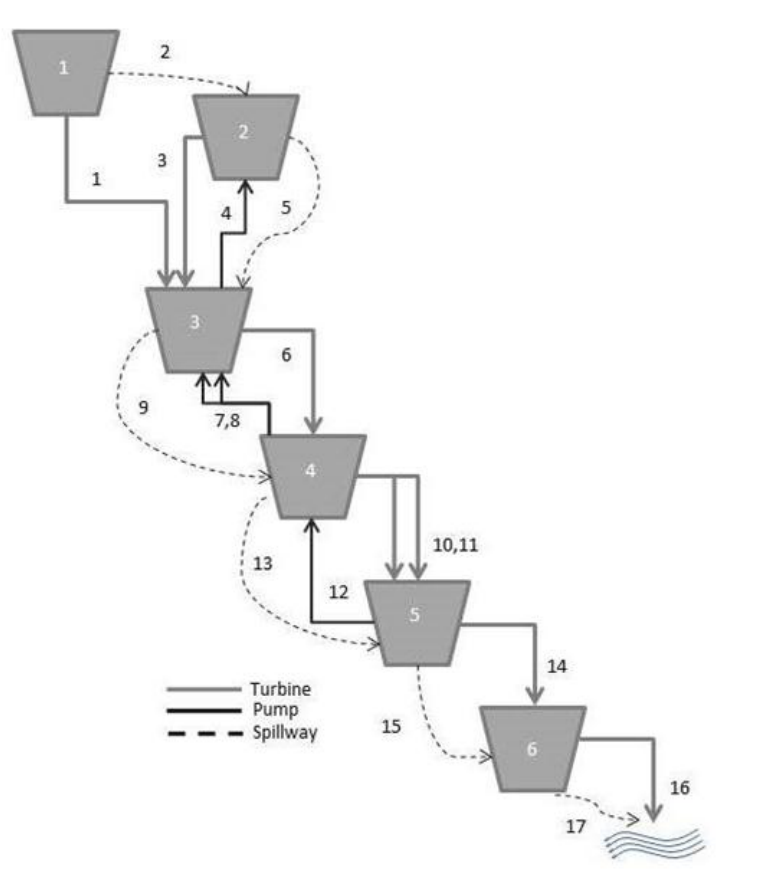
Fig. 1. Hydro system